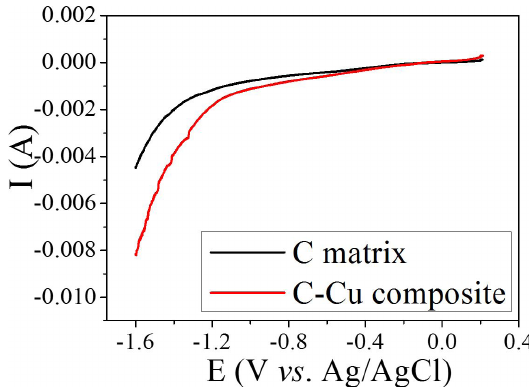
Figure 9. Linear sweep voltammetry curves of the C matrix and the C–Cu composite under CO